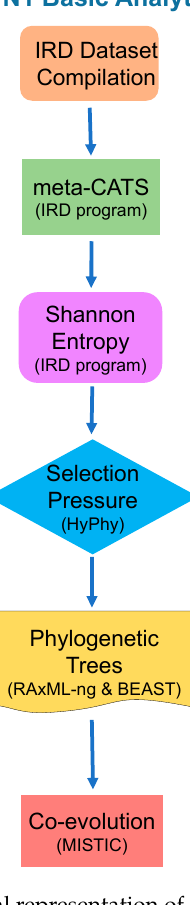
Figure 1. A visual representation of the analytical workflow implemented in the current study.